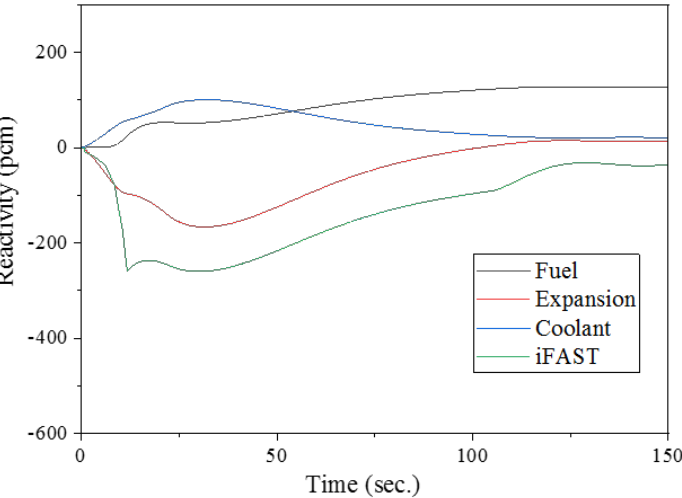
Figure 7. The variation of the reactivity components during ULOF for 1$ maximum iFAST worth and 0.2 m insertion limit.